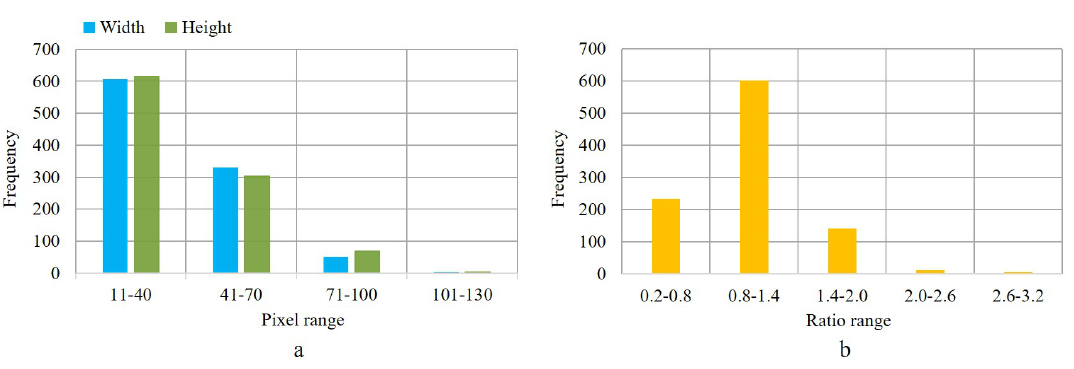
Figure 14. ( a ) The distributions of pixel width and height of tassels. ( b ) The distribution of tassels morphology.